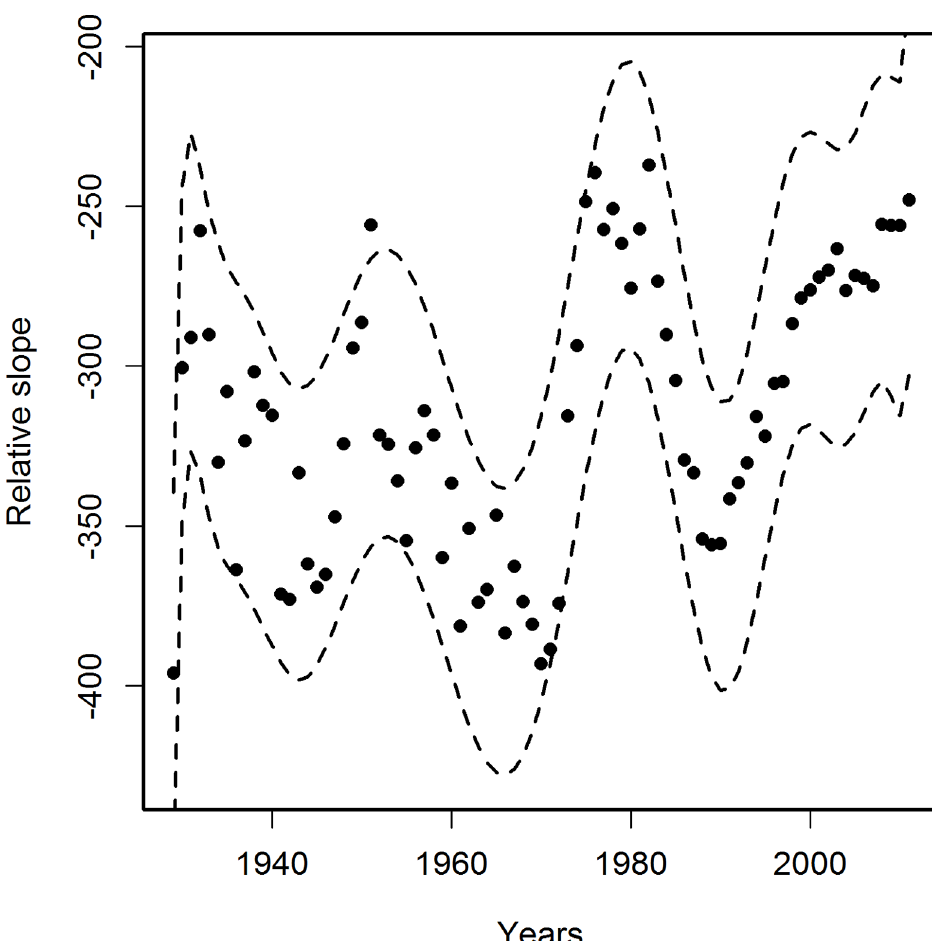
Fig 5. Variability in time of the relative slope of correlations of PCPI for each state with age-adjusted AD death rates (AADRs) for the respective states in 2005. The Relative slope was calculated by dividing slope data from Fig 4 by the coefficient of stratification of PCPI between poorest and richest states; f = PCPI highest/PCPI lowest. This procedure removes the time-dependent influence of stratification of PCPI between states. Solid line regression curve obtained as in Fig 3, dashed lines — 95% confidence intervals. The oscillatory character of the relative slope resembles the oscillations of R in Fig 3. Numbers of states as in legend to Fig 3